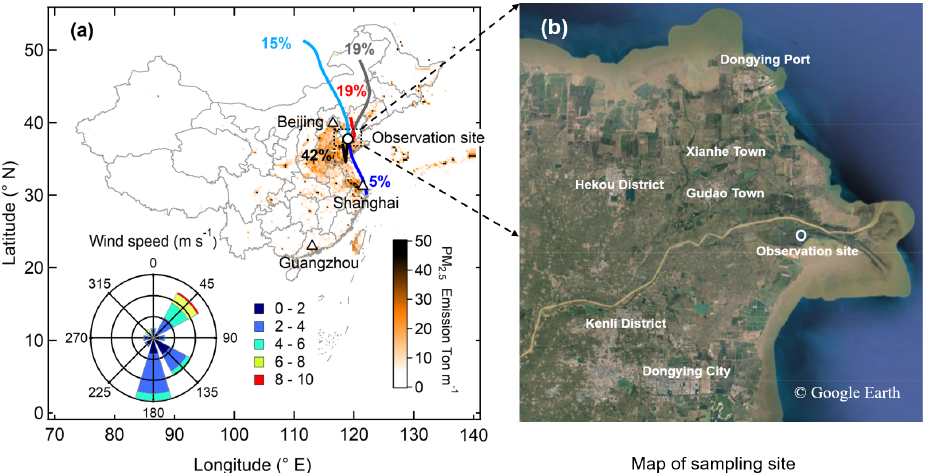
Figure 1. (a) Location of observation site (circle) in China, along with wind speeds, wind directions, and back trajectories of air masses during this campaign. The map is color-coded according to PM 2 . 5 emission inventory (M. Li et al., 2017). (b) Map of the Yellow River Delta National Nature Reserve (YRDNNR) region, labeled with the sampling site (circle) and adjacent cities and towns (source: Google